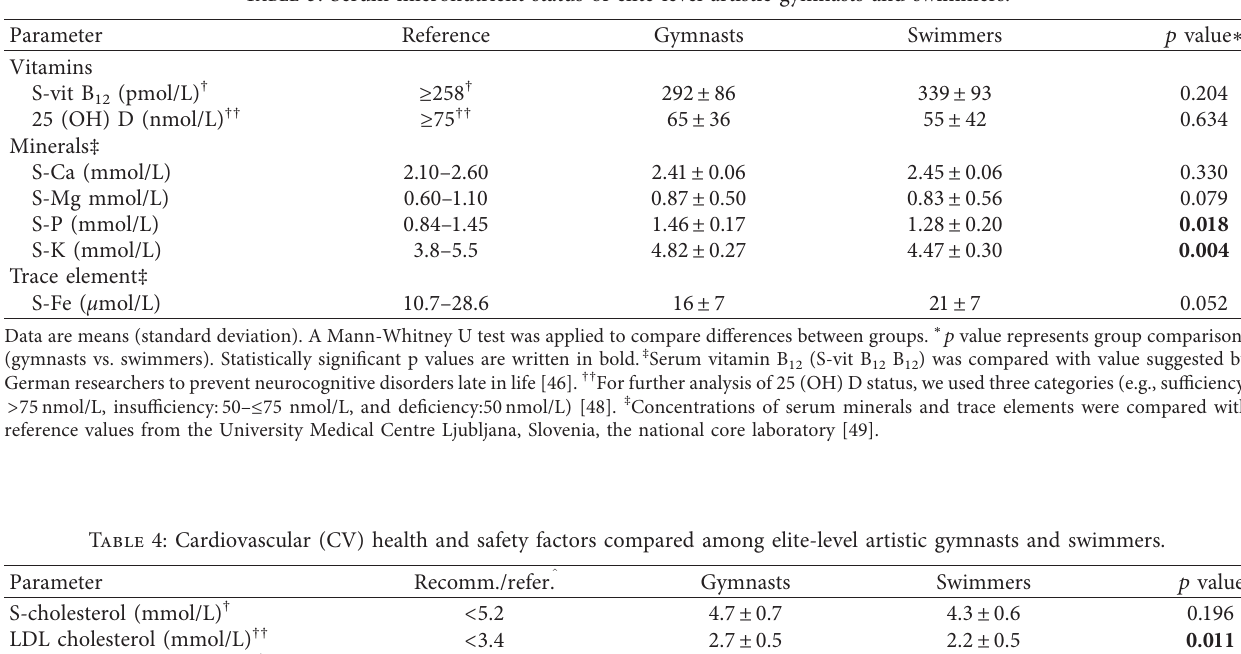
Table 3: Serum micronutrient status of elite-level artistic gymnasts and swimmers.